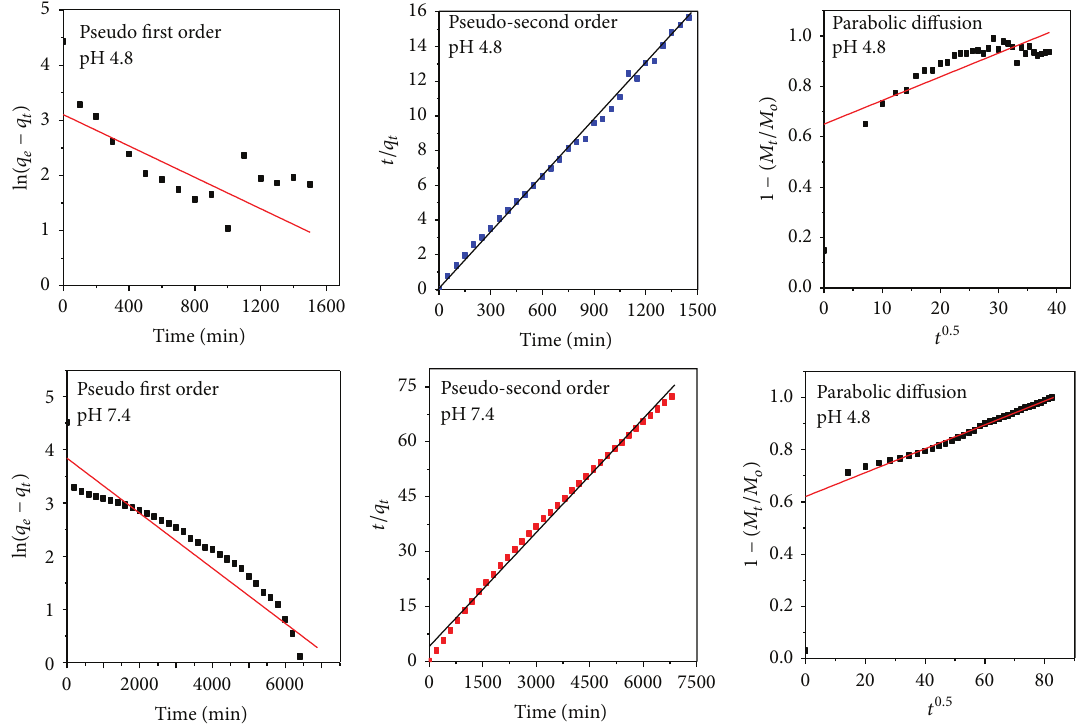
Figure 7: Kinetic fitting data for PAS in vitro release from PAS-ZLH (nanocomposite A) into PBS solutions at pH 7.4 and 4.8 by applying the pseudo-first and pseudo-second-order kinetics and parabolic diffusion